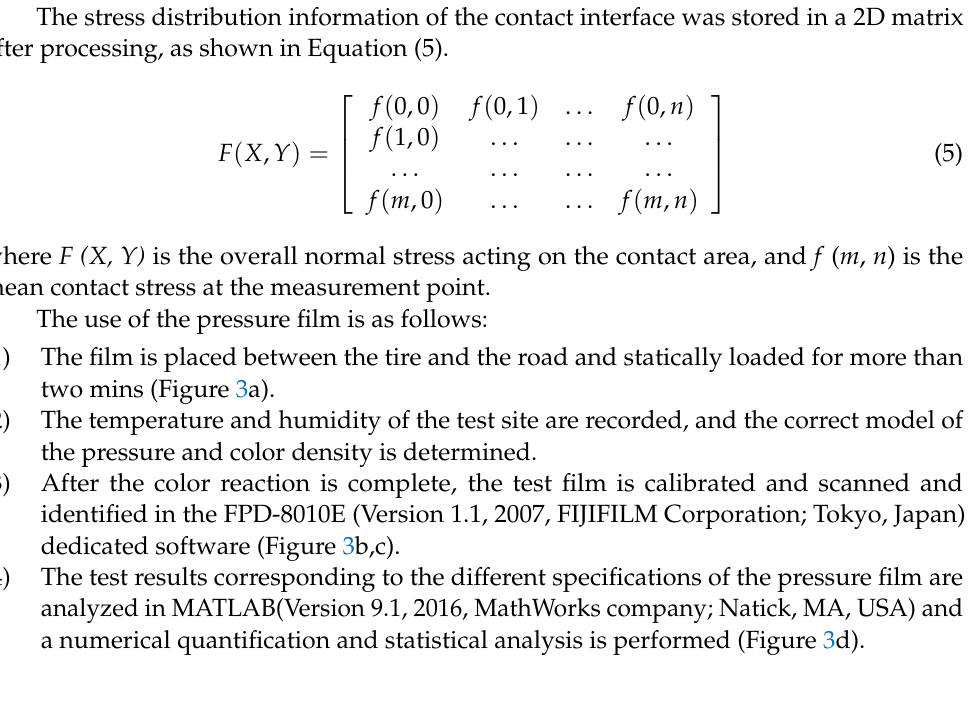
Figure 2. Working principle of a pressure film.